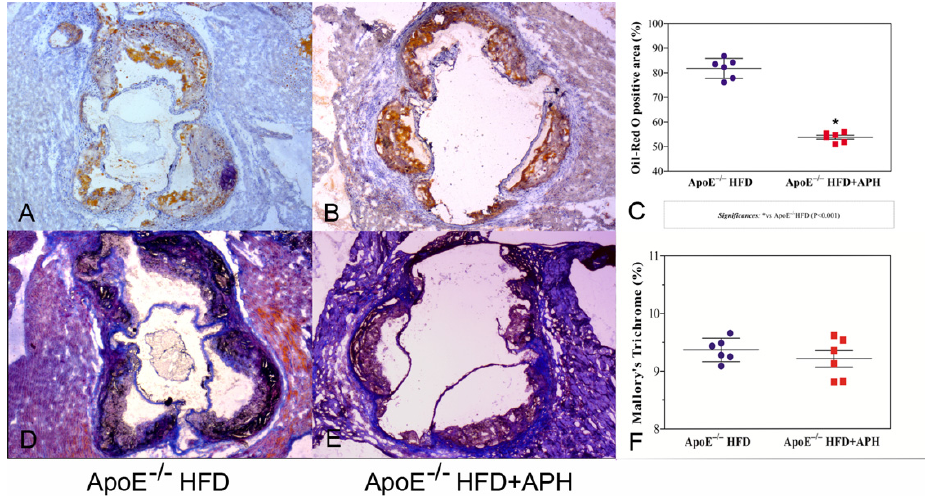
Figure 4. Histochemical characterization of atherosclerotic plaques in aortic sinus of ApoE − / − HFD + APH and ApoE − / − HFD (control) mice. Representative photomicrographs and quantification of lipid deposition in plaque area ( A – C ). Representative photomicrographs and quantification of extracellular matrix deposition ( D – F ). Quantification of lipids and extracellular matrix deposition was expressed as percentage of positively stained area/total plaque area. Quantification is presented as mean ± SD for n = 6 animals per group. (Magnification 5×).